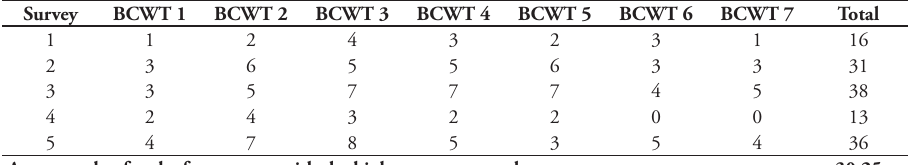
Table 10. Example of calculation of mean value of captured beetles. Subset of traps and surveys used for calculation of the reference value of the monitoring trend of O. eremita population in one site (BCWT: Black Cross Window